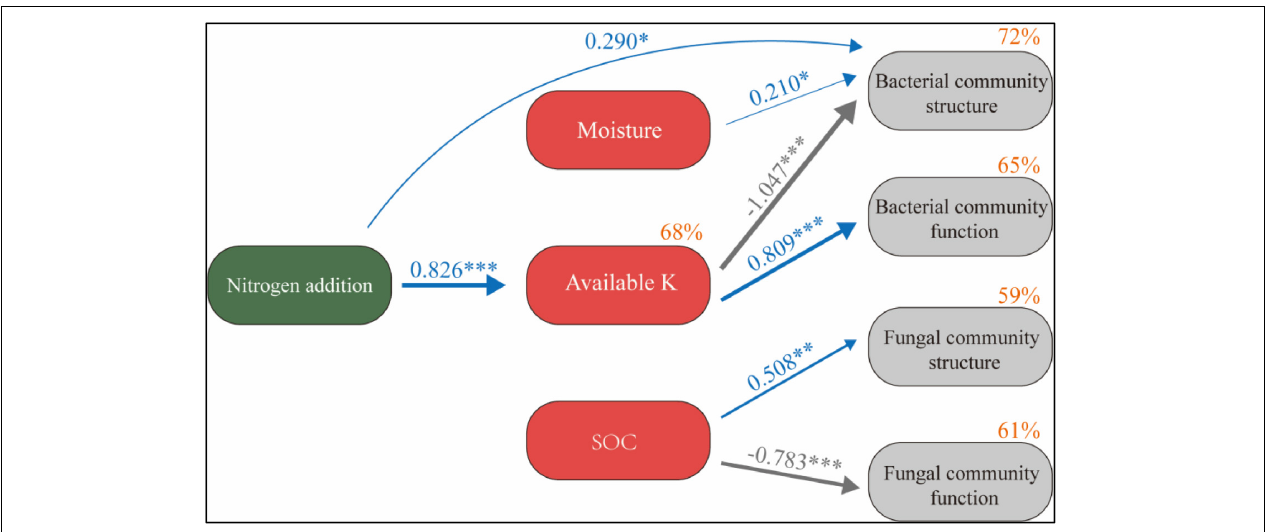
RDA1 indicates the cosine value of the angle between soil factor and ordination axis, and RDA2 indicates the correlation between soil factor and ordination axis. r 2 is the determination coefficient of soil factors in species distribution. The smaller r 2 , the smaller the influence of soil factors on species distribution. P is the significance test of correlation. Bold values indicates P < 0.05.